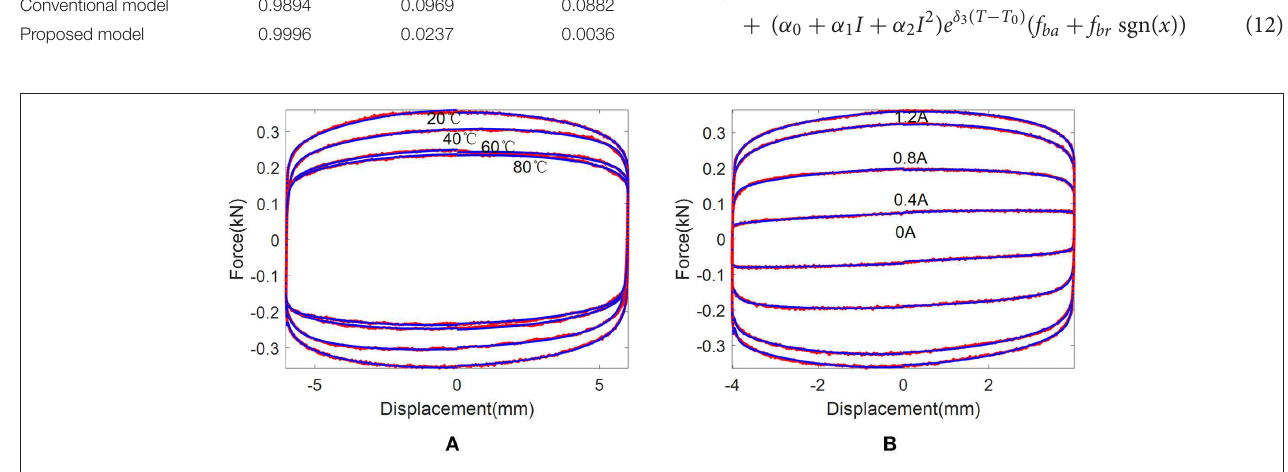
FIGURE 9 | Comparison of the experimental data and the identified results: (A) at different temperatures and (B) at different currents (Red lines-experimental data, blue dots- identified results).